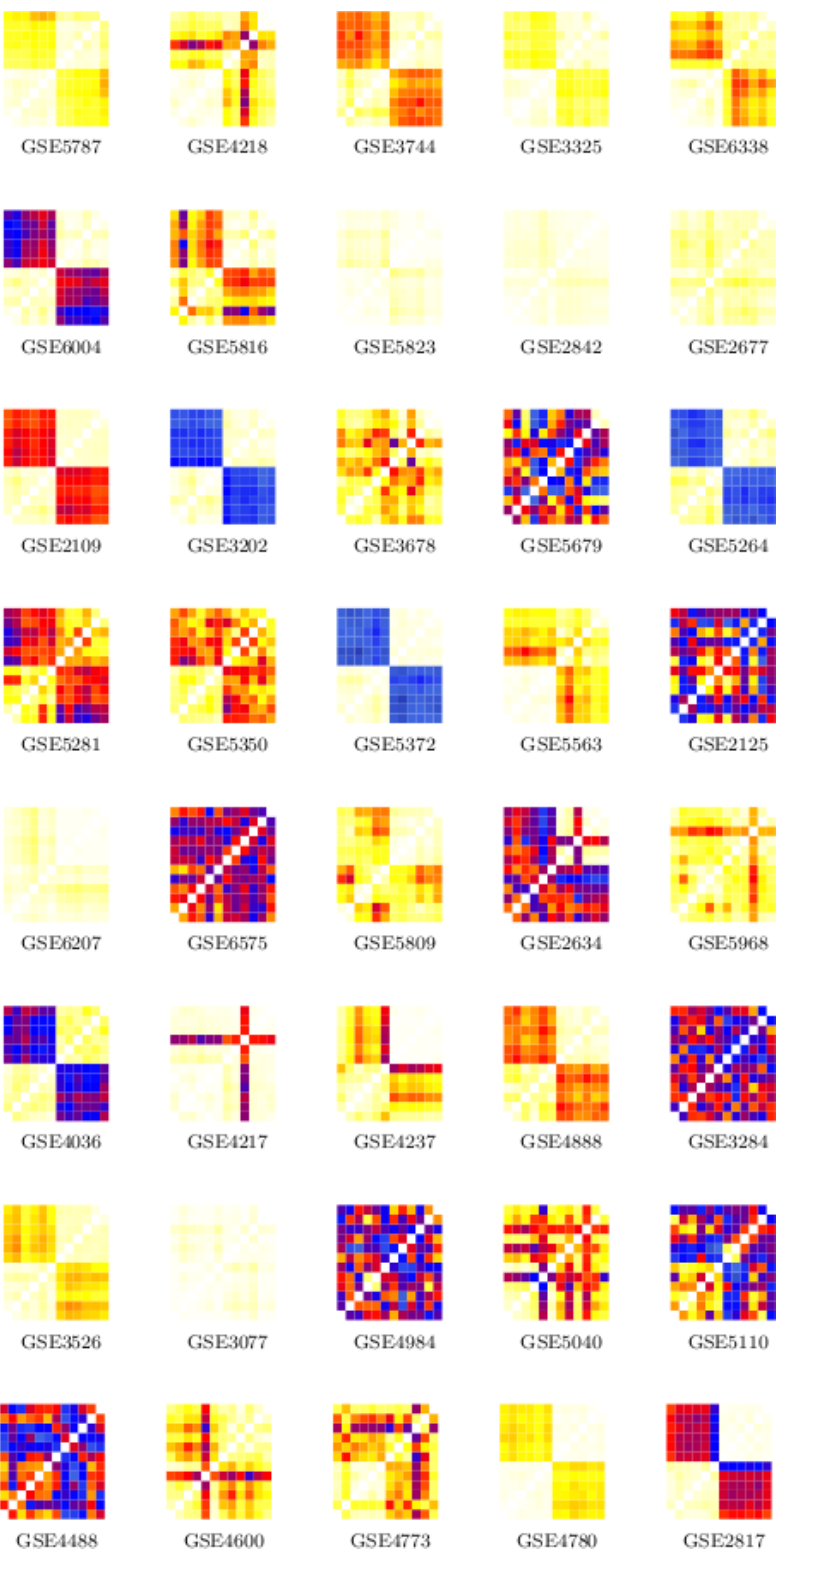
Figure 6. Heatmaps with data from different experiments for exon ENSE00001452067. The heatmap representing the overall experiments is in Table 1 pattern 4 (the antisense probes are correlated, the sense probes are correlated, and the sense probes are not correlated or are weakly correlated with the antisense